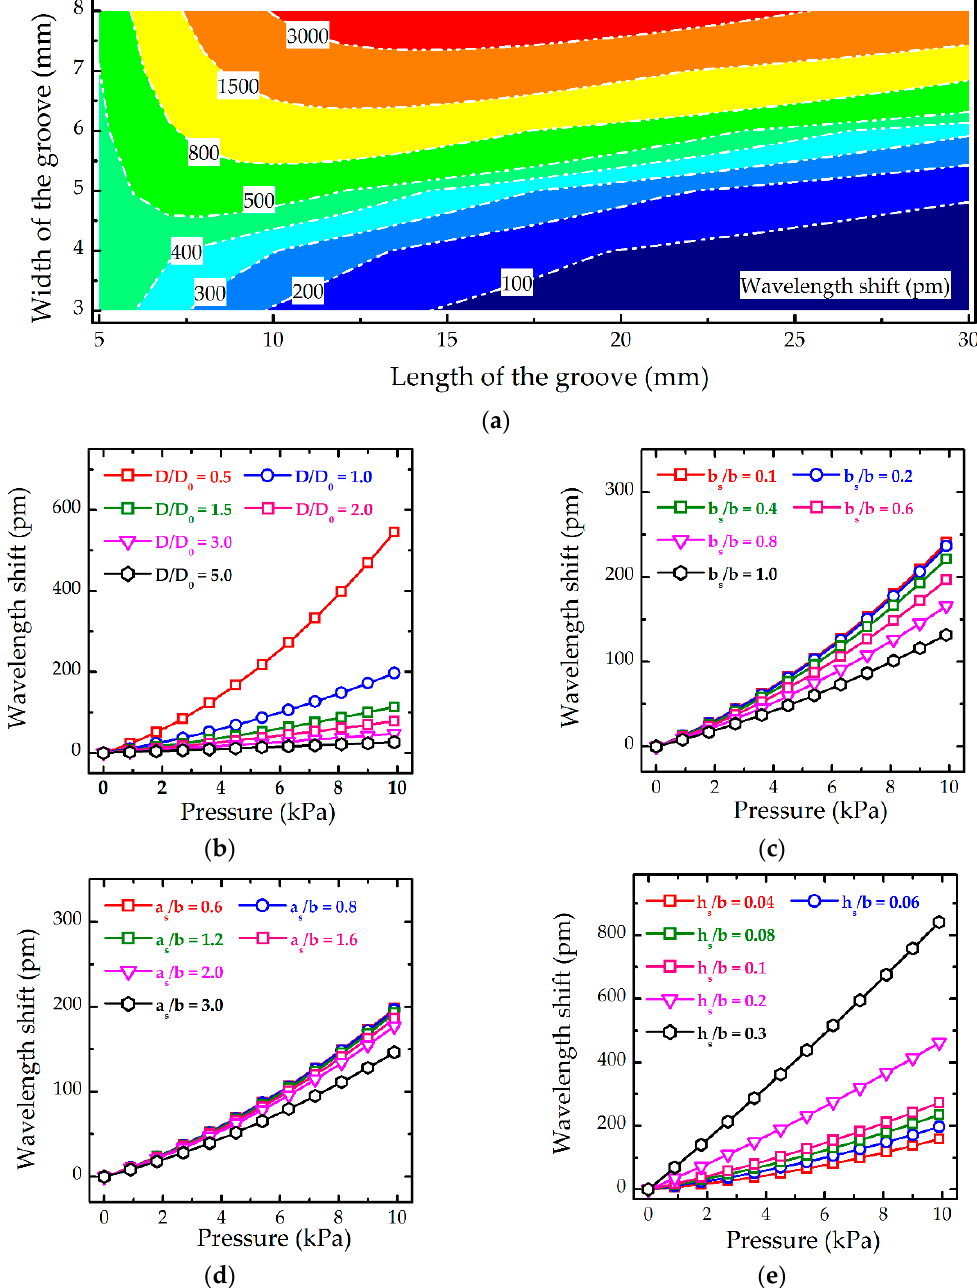
Figure 2. Effects of parameters on the wavelength shift of the proposed optical sensor based on the theoretical models: ( a ) length, a , and width, b , of the groove, where the wavelength shift of FBGs is obtained at the applied pressure of 10 kPa; ( b ) Effective stiffness of the thin plate, D , where D 0 is calculated based on the parameters listed in Table 1; ( c ) Width of the spacer, b s ; ( d ) Length of the spacer, a s ; and ( e ) Thickness of the spacer, h s . Without specification, all the parameters utilised in calculation are listed in Table 1.